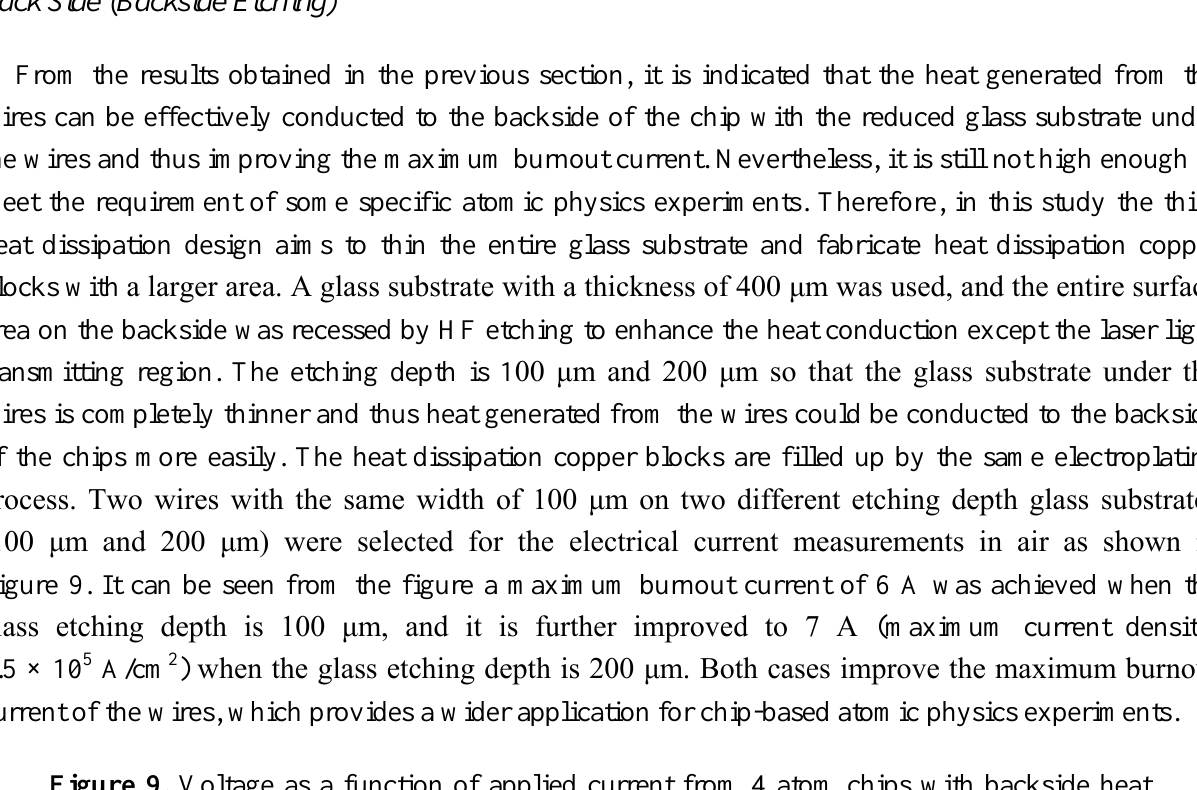
Figure 9. Voltage as a function of applied current from 4 atom chips with backside heat dissipation design (backside etching depth: 100 μm and 200 μm) under different test conditions. “air” and “vacuum” refer to the test being performed at 1 atmosphere and at 1 × 10 −2 Torr. All the measurements stop at a certain point where the wires